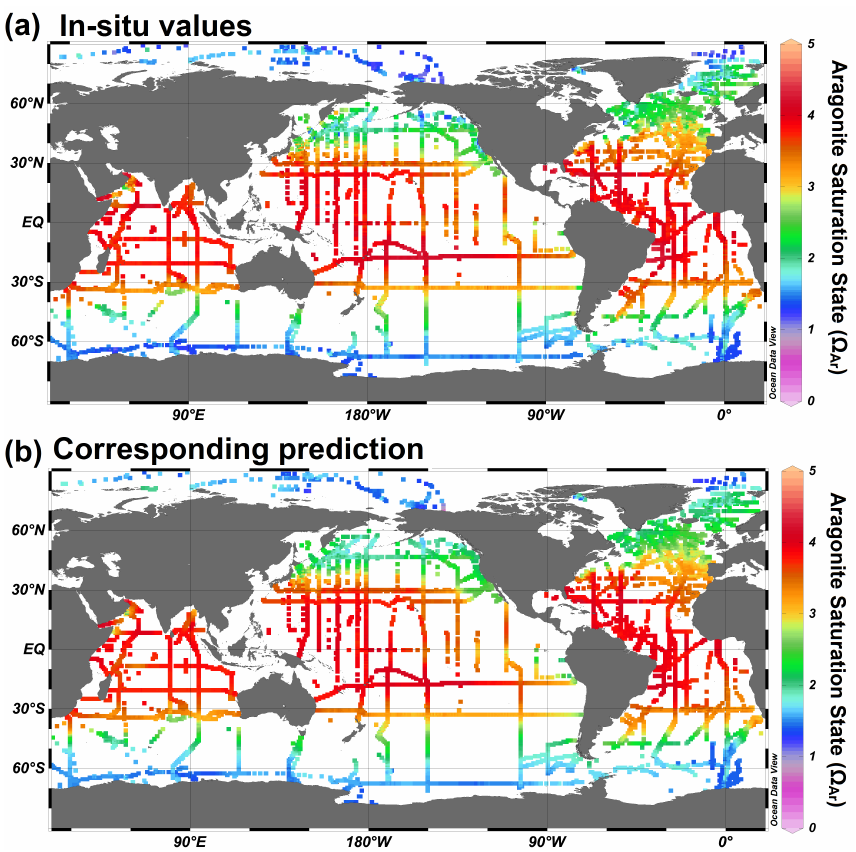
Figure 1. (a) In situ (cid:127) Ar measurements normalized to the year 2000; (b) corresponding 1 ◦ × 1 ◦ (cid:127) Ar prediction for the same month and location for the nominal year for 2000 (see Supplement Fig. S1 for our monthly (cid:127) Ar distributions).